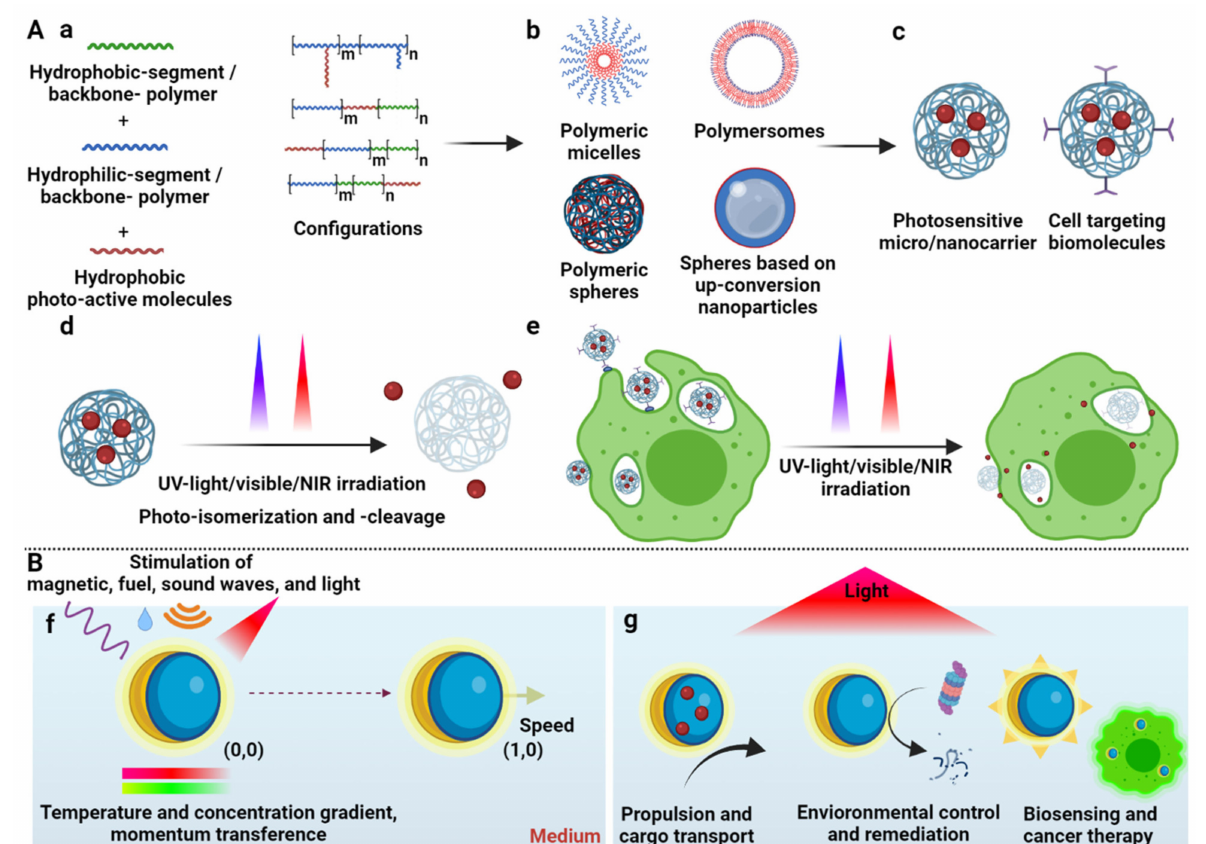
Figure 1. Schematic illustration of polymeric ( A ) micro/nano-carriers and ( B ) motors for cargo transport and phototriggered delivery. Photosensitive polymer synthesis ( a ), photosensitive polymeric micro/nanocarriers ( b ), and polymeric micelles are represented by red hydrophobic and green hydrophilic segments; polymersomes by blue hydrophilic and red hydrophobic segments; polymeric solid spheres by a red backbone polymer dispersion; and spheres by gray upconversion nanoparticles, blue polymer, and red photoactive molecules. Cargo transport and functionalization for targeting cells ( c ); cargo photorelease concept ( d ); cellular environment for biomedical applications ( e ); cargo concept (red) and cell-targeting biomolecules (purple), polymeric micro/nanomotors ( f ), and light-stimulated polymeric micro/nanomotor applications ( g